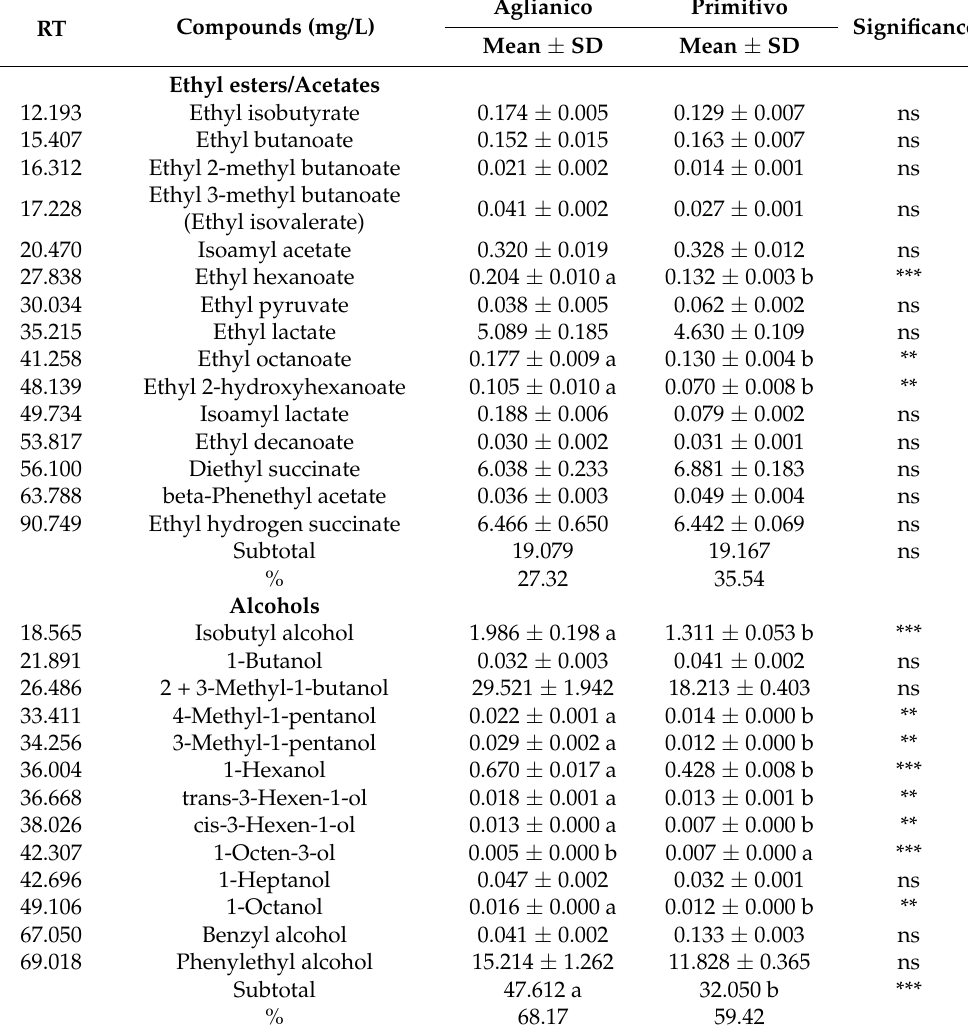
Table 1. VOCs detected and semi-quantified (mg/L are calculated as a ratio of each compound’s response to the response of the internal standard) by LLE/GC-MS in both Aglianico and Primitivo wines. Standard deviation (SD) and significance (one-way ANOVA) are